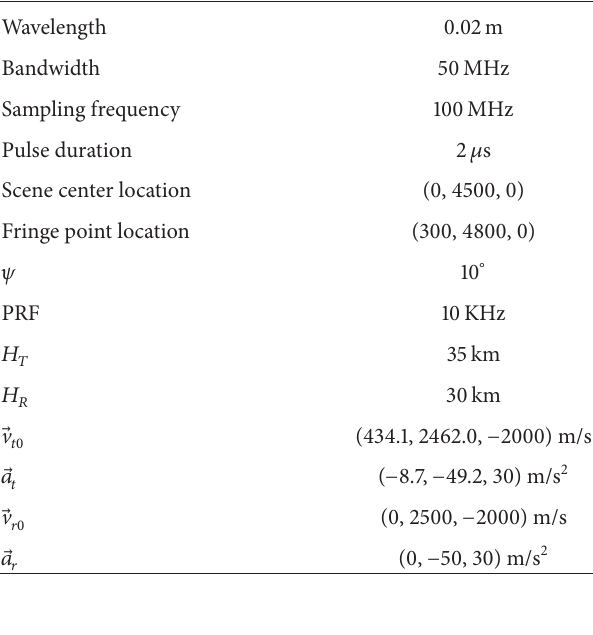
Table 1: Parameters used in the